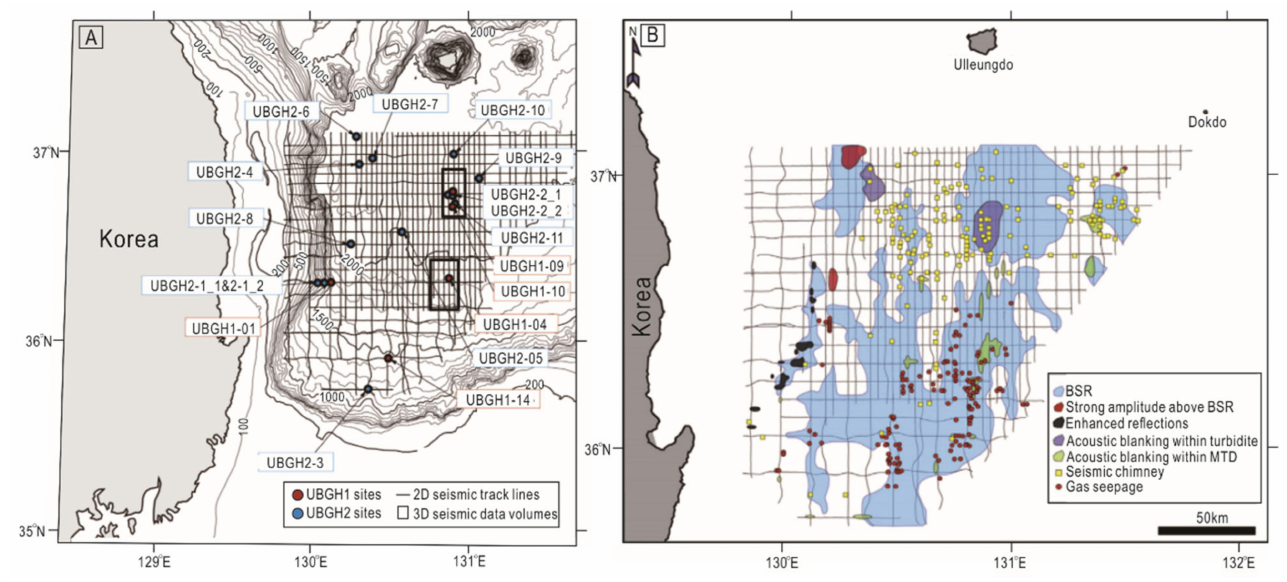
Figure 4. ( A ) UBGH1 (red dots) and UBGH2 (blue dots) drilling sites (cited from [22,26]). ( B ) Map depicting the distributions of seismic indicators associated with gas hydrates in the Ulleung Basin (cited from